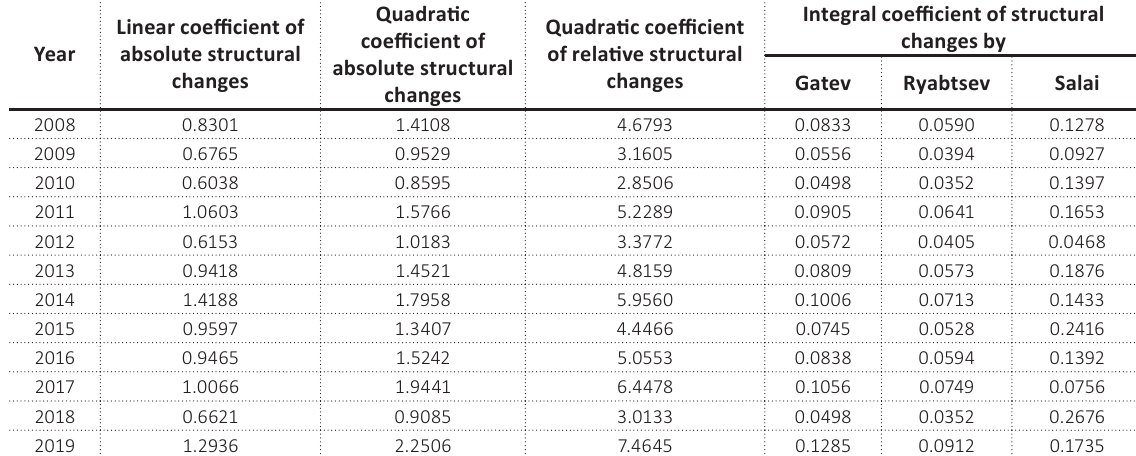
Table 3. Indicators of dynamics and variations of structural changes in expenditure side of the state budget of